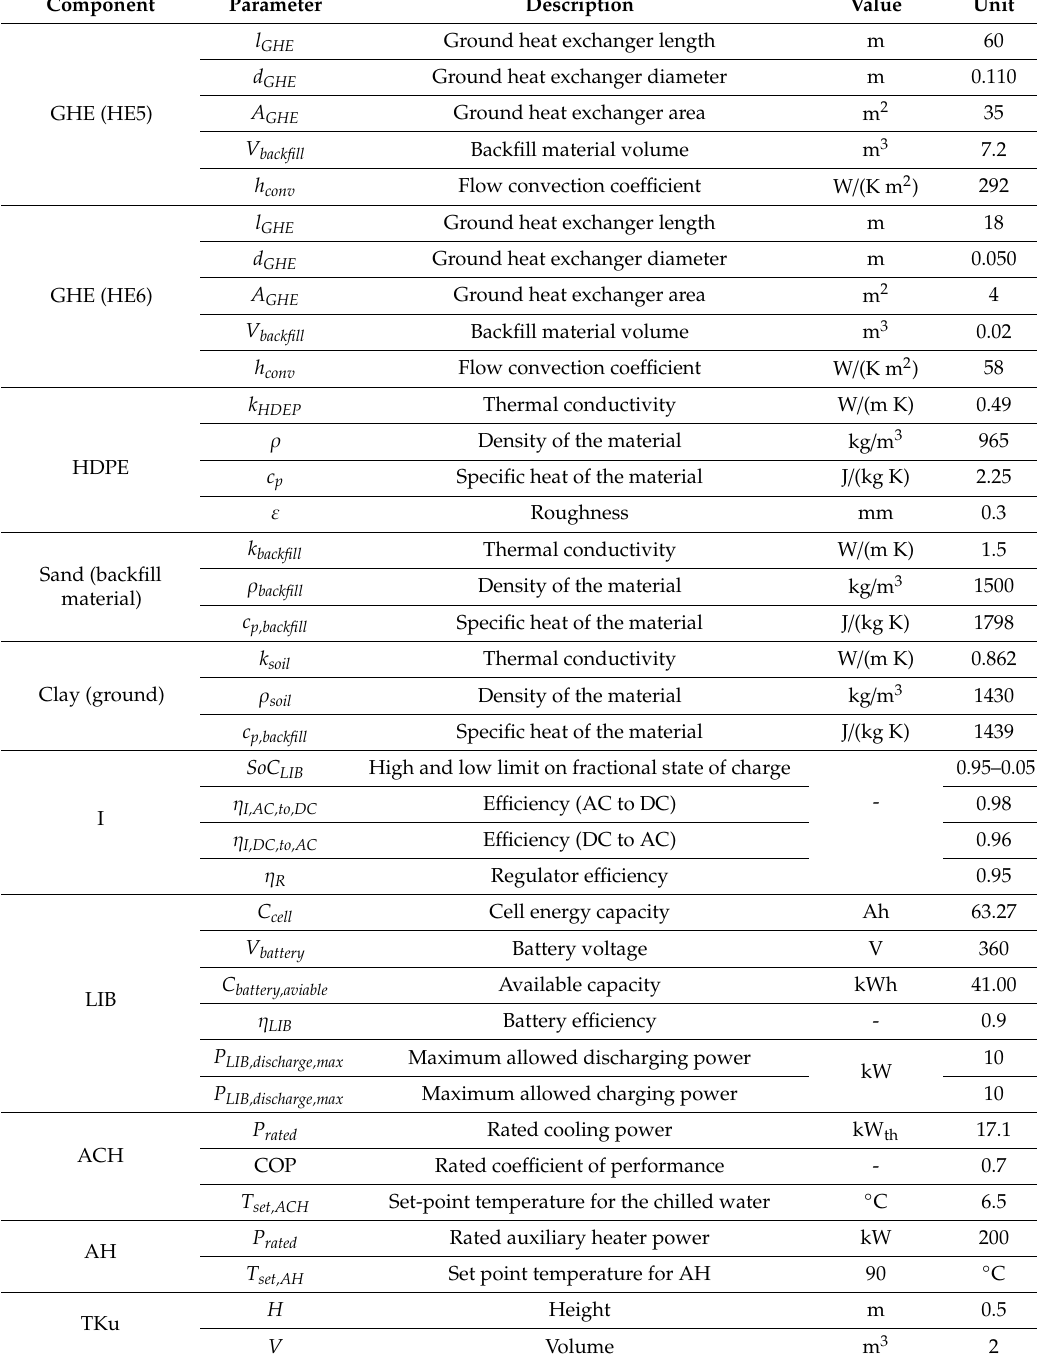
Table 2. Design and operating parameters